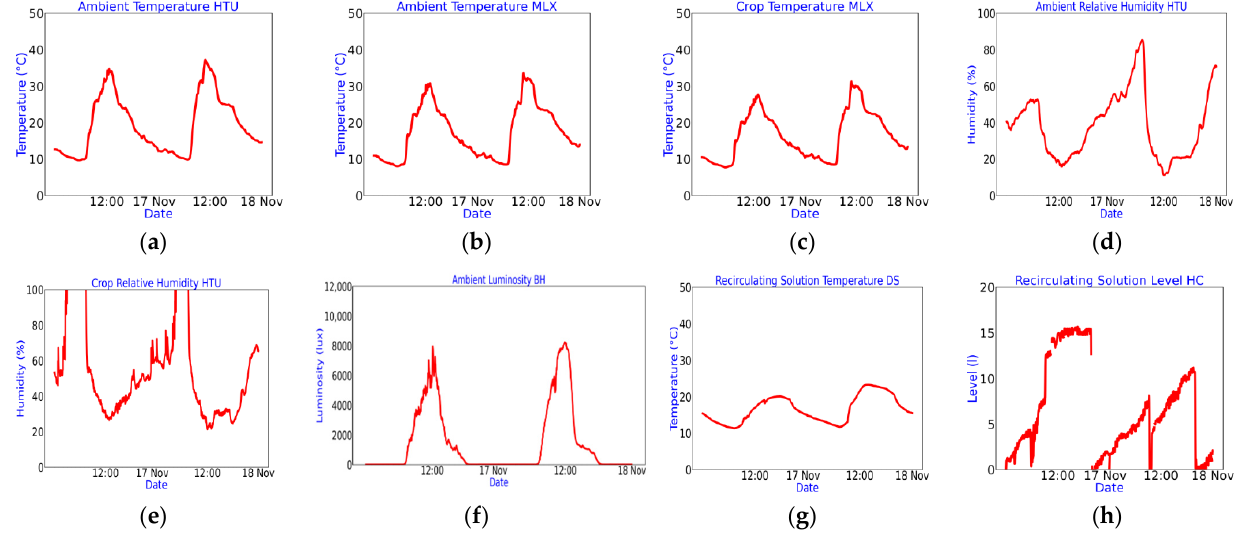
Figure 6. Recording of environmental variables in a Thingspeak channel. ( a ) Environmental temperature of the HTU21D sensor; ( b ) environmental temperature of the MLX90614 sensor; ( c ) crop temperature; ( d ) relative humidity; ( e ) relative humidity in the crop; ( f ) luminosity; ( g ) temperature of the recirculating solution; ( h ) level of recirculating solution.